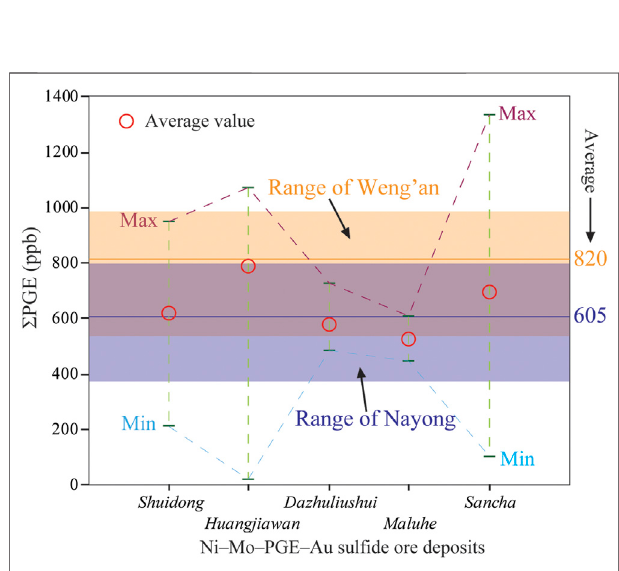
FIGURE 4 | Comparison of Σ PGE values of the lower Cambrian black- shale polymetallic layer in Hunan – Guizhou (after Li and Gao, 2000; Mao et al., 2002; Luo et al., 2003; Lehmann et al., 2007; Han et al., 2015).